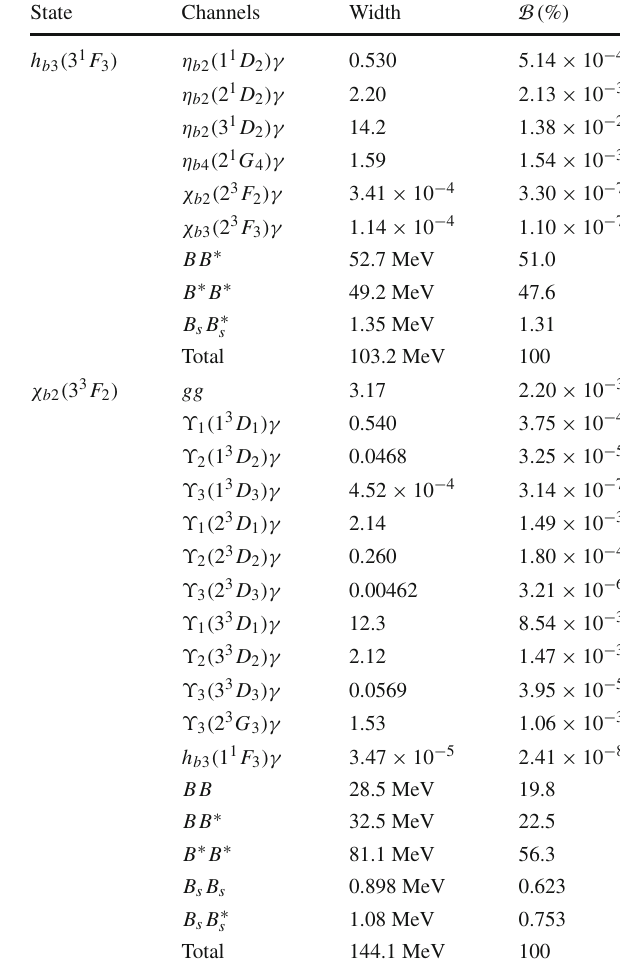
Table34 PartialwidthsandbranchingratiosoftheOZI-allowedstrong decay, annihilation decay, and radiative transition and the total widths for 3 1 F 3 and 3 3 F 2 bottomonium states. The width results are in